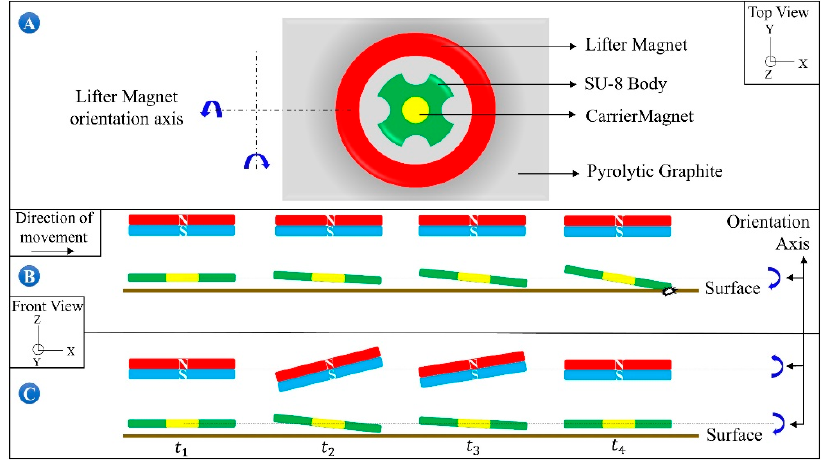
Figure 7. Microrobot study limits are determined. Accordingly, the minimum and maximum points are shown in the range of 31.0 µm (red)–329.1 µm (blue).